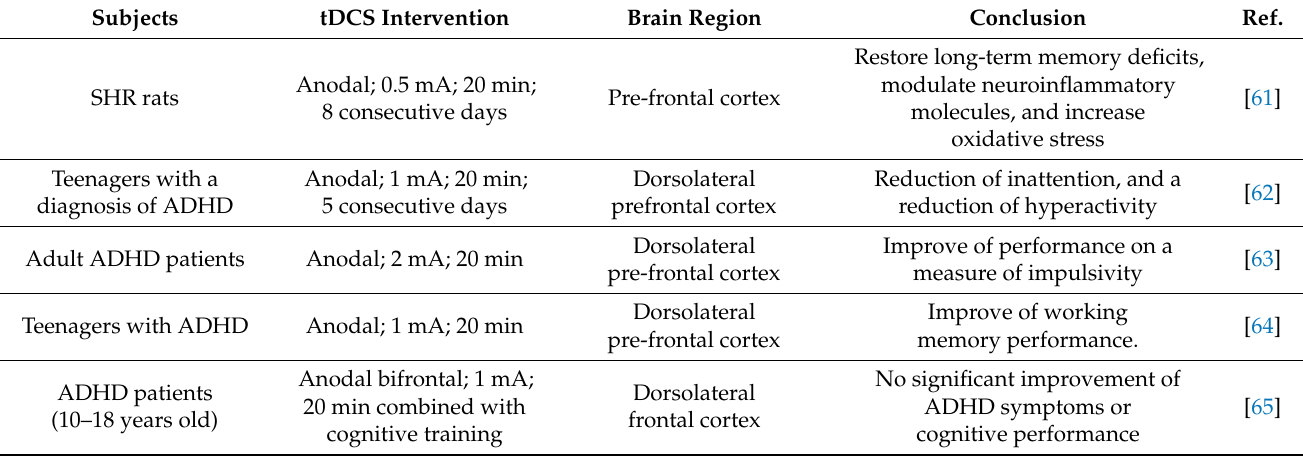
Table 3. Summary of studies on the effects of tDCS on Attention Deficit/Hyperactivity Disorder (ADHD).